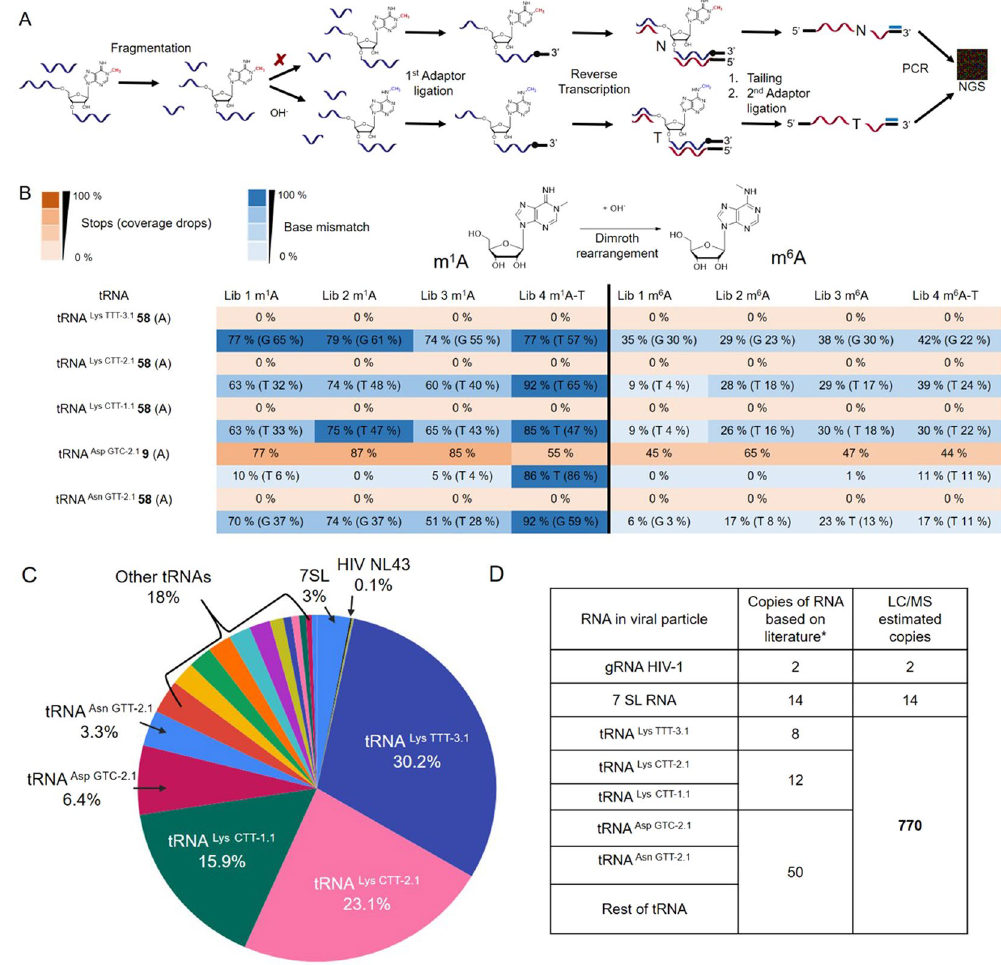
meeting m 1 A in position 1317 in 80%. This is contrary to the reverse transcriptase TGIRT TM , which misread the